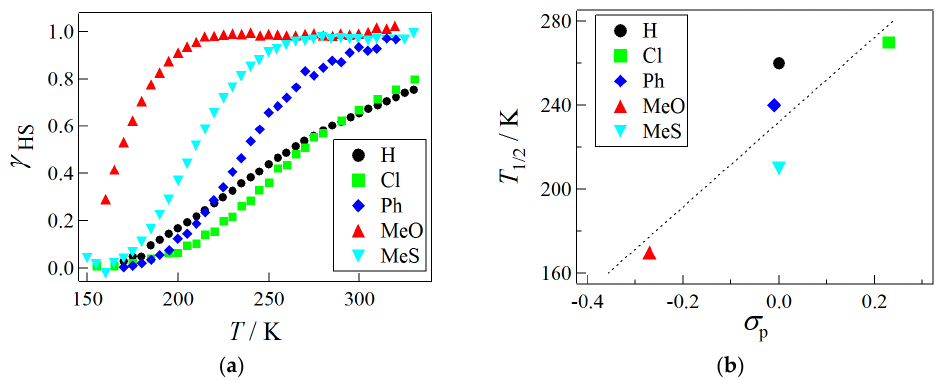
Figure 3. ( a ) Temperature dependence of the HS (high-spin) molar fraction γ HS for acetone solutions of [Fe(X-pybox) 2 ](ClO 4 ) 2 , measured at 5000 Oe. ( b ) The spin transition temperature T 1/2 as a function of the Hammett substituent constant σ p . A dotted line represents the best linear fit.